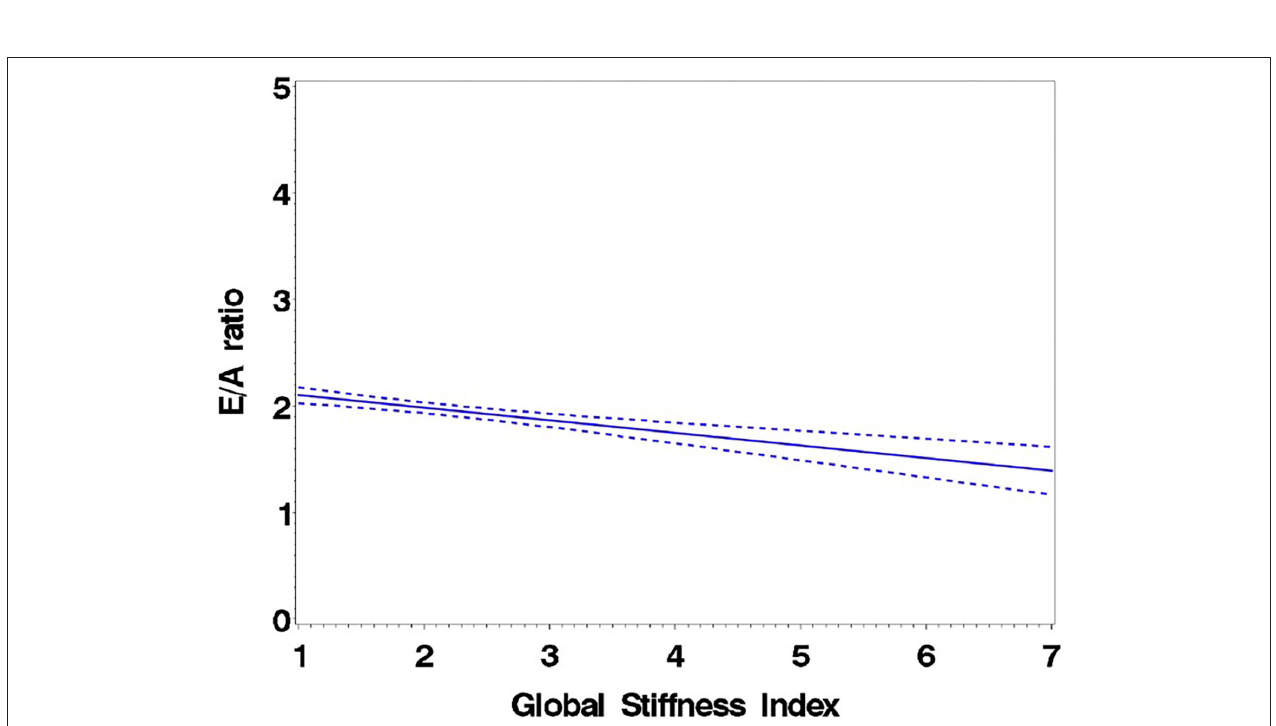
Frontiers in Pediatrics |